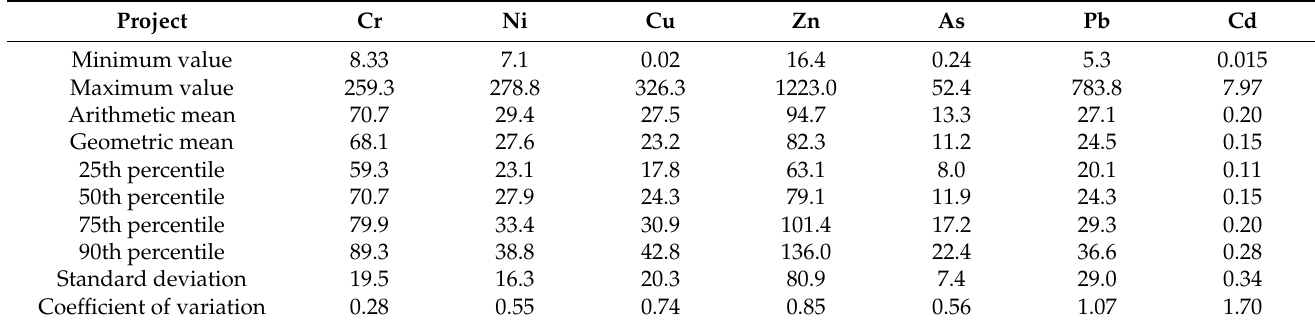
Table 1. Statistic of heavy metal concentrations in the soil of Tianjin